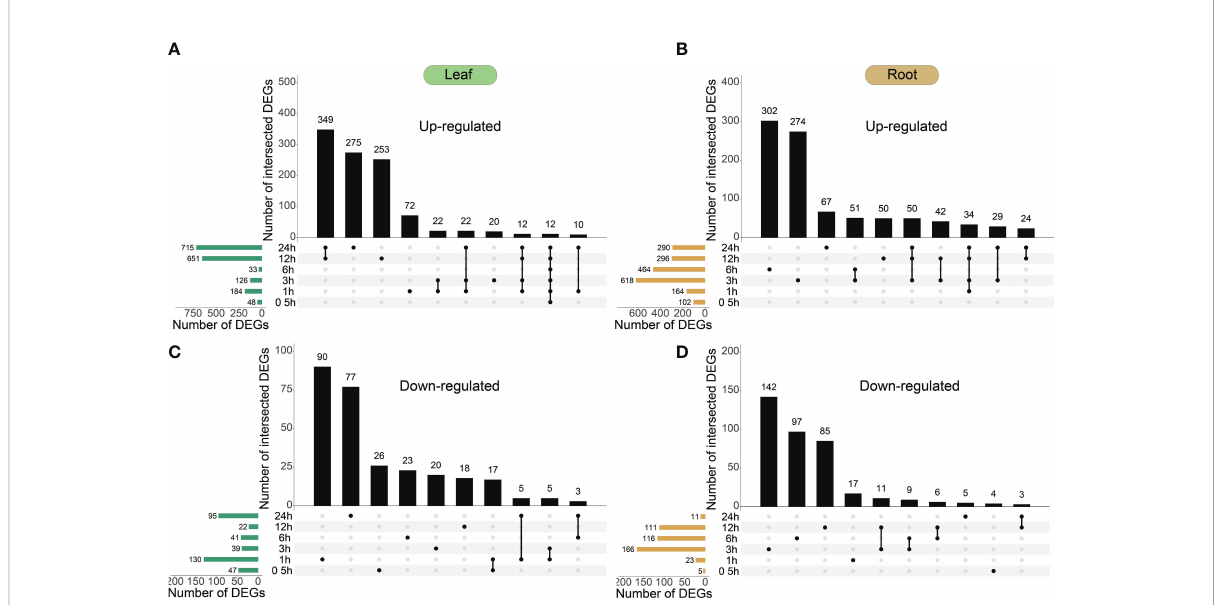
FIGURE 3 Temporal dynamics of Capsicum annuum L. transcriptome during H 2 O 2 treatment. (A – D) , the 40-day-old C. annuum L. plants were treated with 30 mM H 2 O 2 in liquid media and harvested at the given time points for transcriptome analysis. UpSet plots of the number of upregulated and downregulated genes (cut-off threshold, |log2(FC)| ≥ 2; FDR <0.01) demonstrating different temporal expression patterns (top bar graphs). The total number of upregulated and downregulated genes at each time point is shown on the left. All leaf and root DEGs show in Supplementary Table